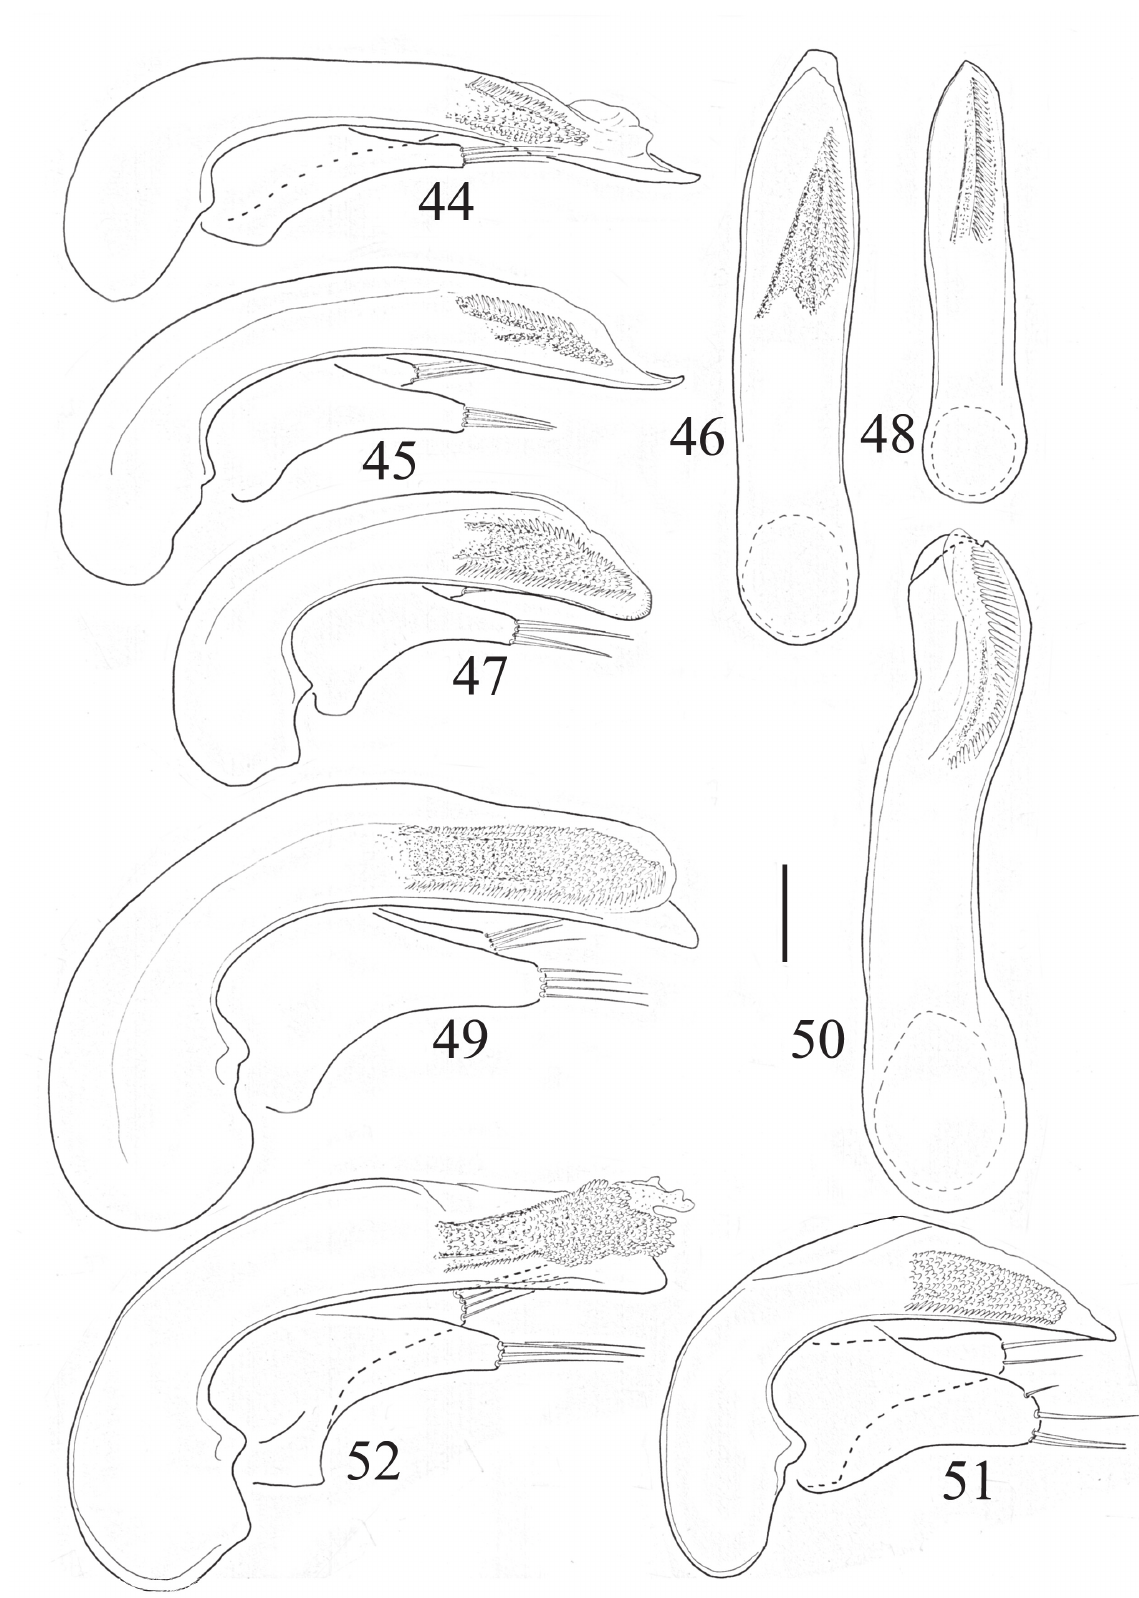
Figs 44-52. Aedeagus in lateral (44, 45, 47, 49, 52) and dorsal (46, 48, 50) view of Tasmanorites spp.: 44) T. tasmaniae (Blackburn) HT ♂, from Tasmania; 45, 46) T. tasmaniae (Blackburn) CT ♂, from Tasmania; 47, 48) T. daccordii sp. nov., HT ♂ from Cradle Plateau; 49, 50) T. blackburni (Sloane), LT ♂ from Cradle Mtn.; 51) T. glaebarum Moore, ♂ from Mt. Field; 52) T. intermedius Moore, ♂ from Mt. Field. Scale: 0.1